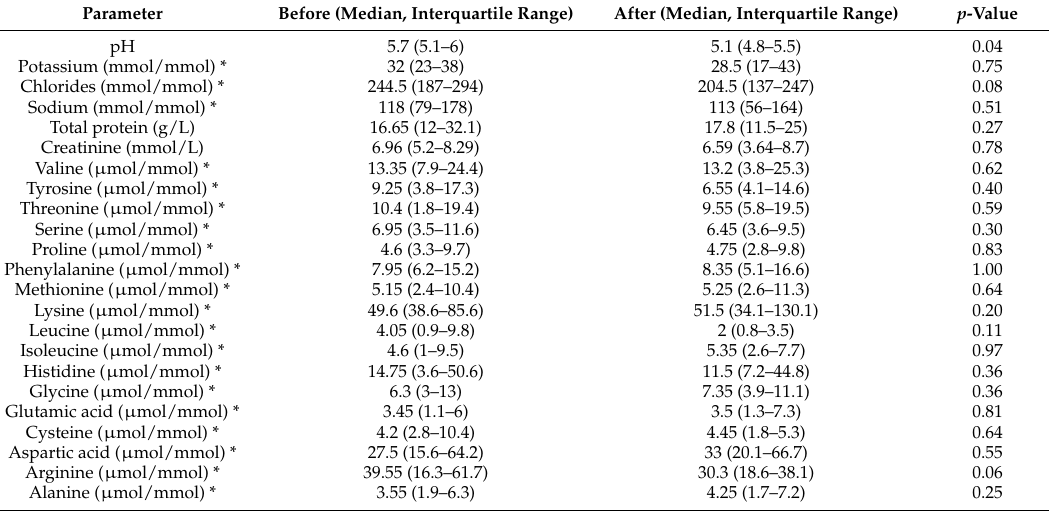
Table 3. Urinary markers of tested cohorts; results of the Wilcoxon matched pairs test. Parameter